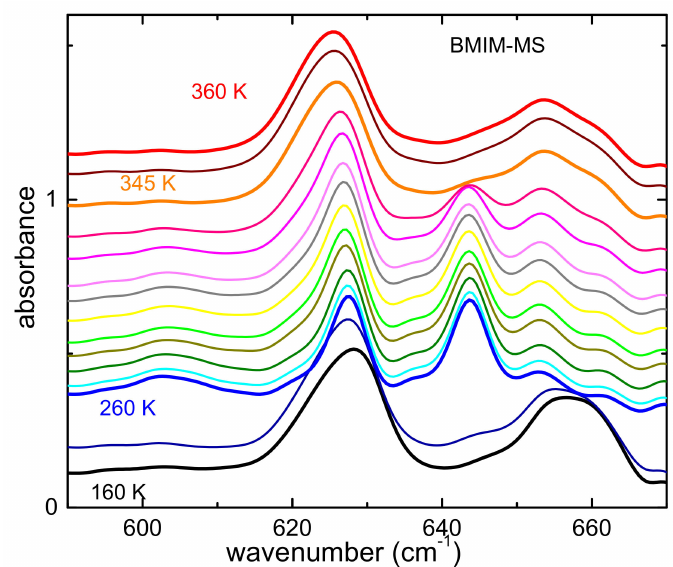
Figure 5. Absorbance of BMIM-MS measured on heating between 600 and 680 cm − 1 . The curves are vertically shifted for reasons of